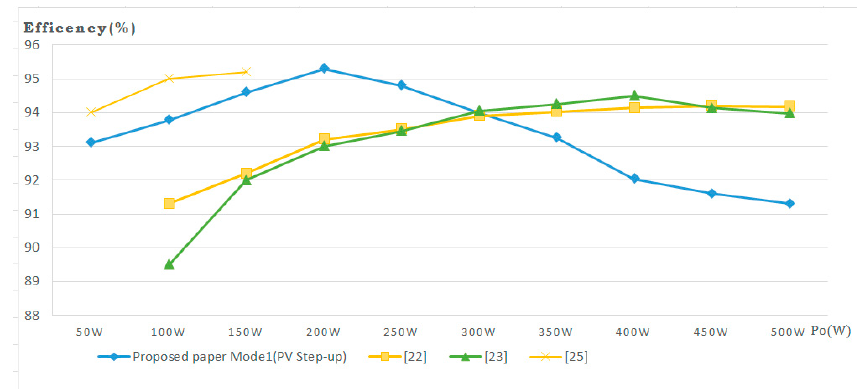
Figure 18. Comparison of efficiency of proposed converter with those of converters proposed in [23–25] in step-up mode.